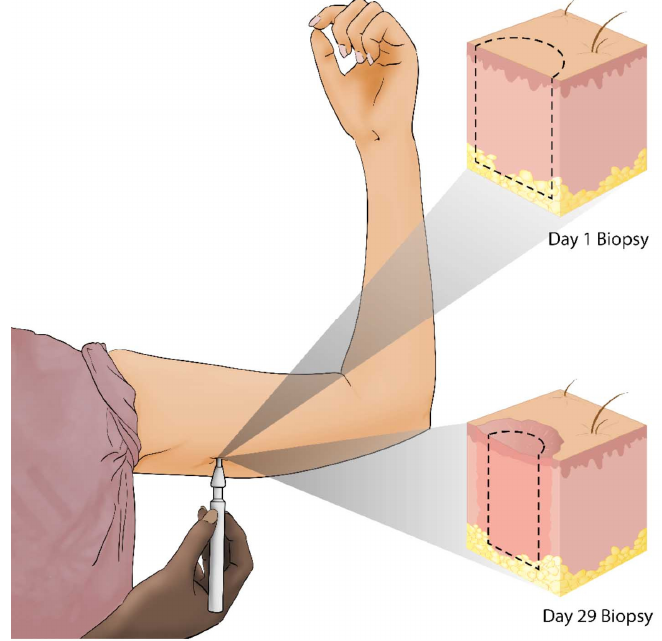
Figure 2. Alpha connexin carboxyl terminus 1 ( α CT1) Phase I clinical trial sampling scheme, performed on healthy human volunteers.